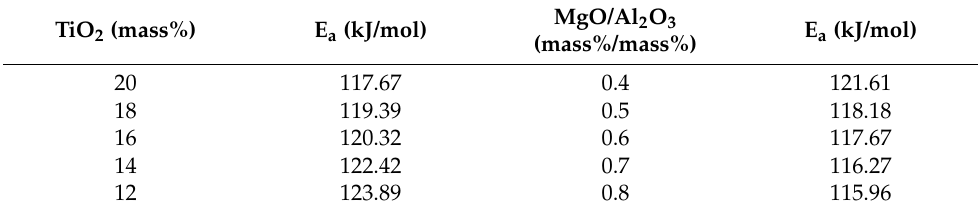
Figure 9. Temperature dependence of the viscosity of the slags ( a ) with varying TiO 2 content; ( b ) with varying MgO/Al 2 O 3 ratio. Table 2. The calculated results of apparent activation